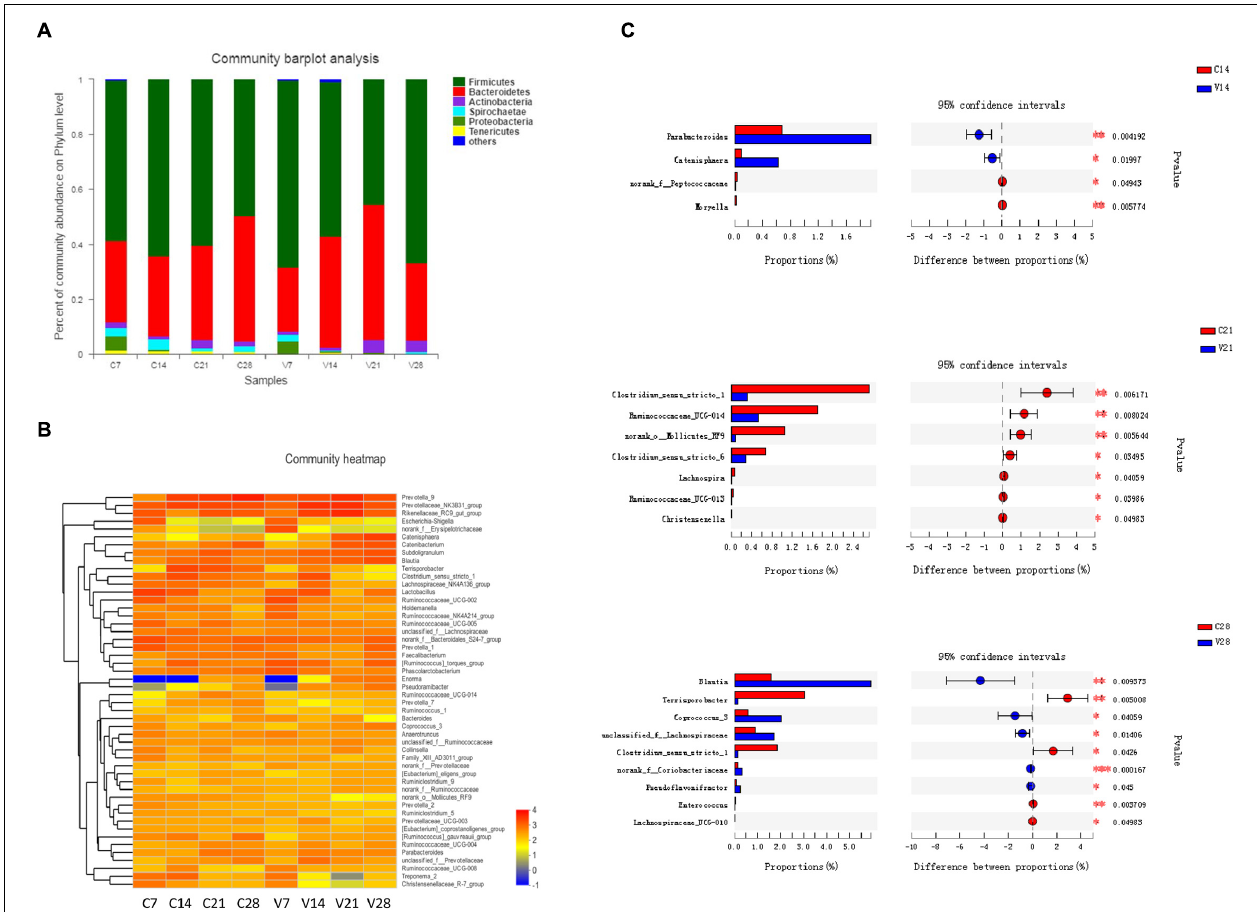
FIGURE 4 | Relative abundance analysis of bacterial phyla and genera in PCV3- (V) and sham-inoculated (C) piglets. (A) Community bar-plot analysis represents relative abundance of sequences at the phylum level. (B) The heatmap depicts the percentage analysis of abundant genera in PCV3- (V) and sham-inoculated (C) piglets. The X and Y -axes represent the different groups and bacterial genera, respectively. Different color spots represent relative values (lg) of abundance. (C) The barplot illustrates the difference in predominant bacterial genera between PCV3- (V) from sham-inoculated (C) piglets at 14, 21, and 28 dpi. Statistical analysis was performed. Values are expressed as mean ± SD, with four piglets per group. * P < 0.05; ** P < 0.01; and *** P < 0.001.